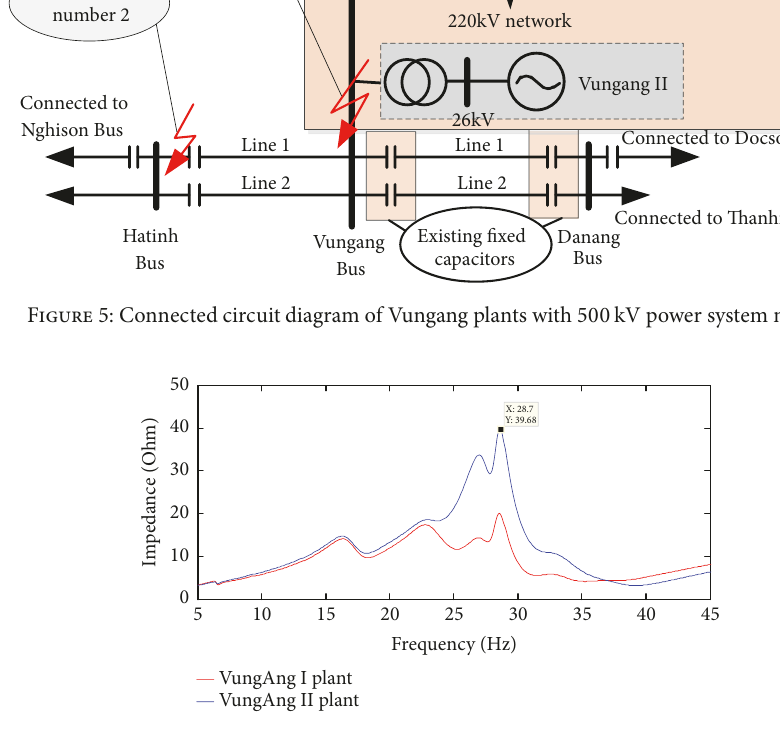
Figure 6: Frequency response of 55 percent compensated transmission